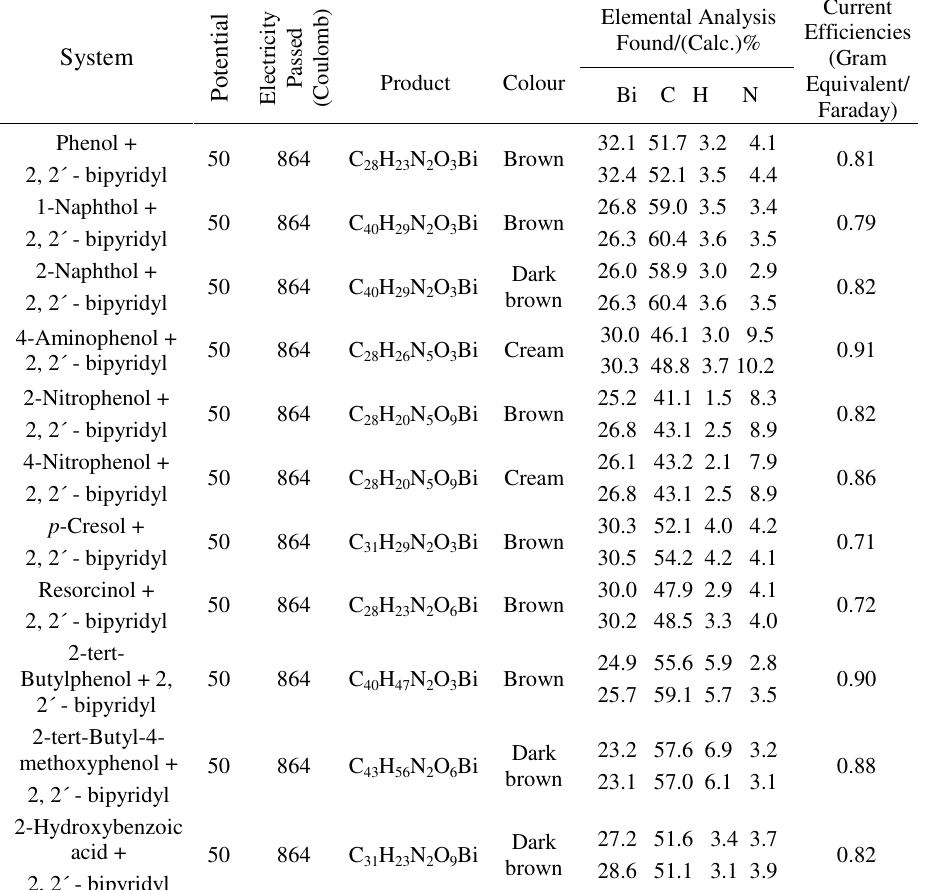
Table 3. Electrolysis characteristics, analytical and other related data of electrolytic product of various phenol systems + 2, 2´- bipyridyl at bismuth anode System e Product Colour o t P